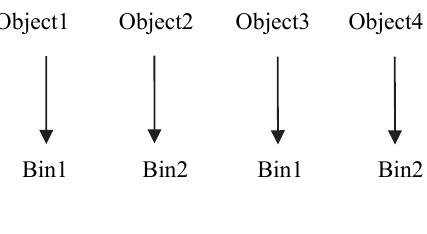
Fig. 4. Solution representation